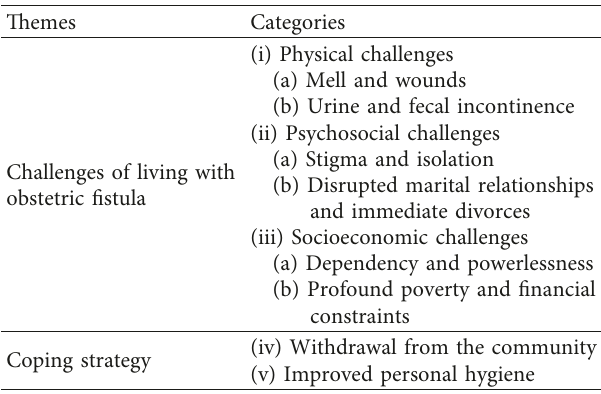
Table 2: Themes and categories that emerged.